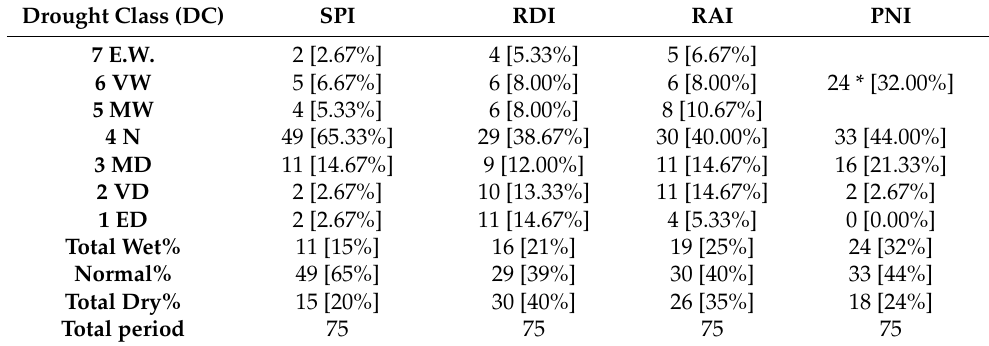
Table 3. Drought class DC, annual frequencies and their percentages for SPI, RDI, RAI, and PNI.